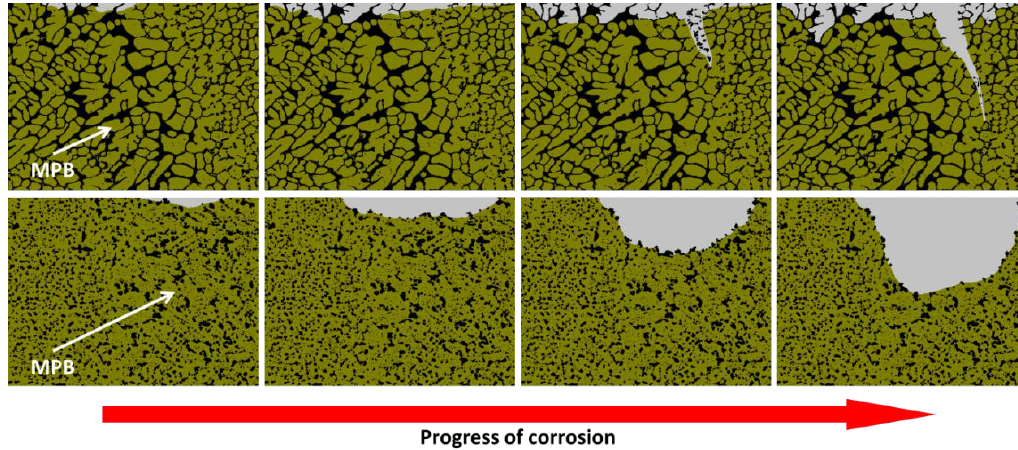
Figure 10. Schematic diagram representing the evolution of the corrosion attack for two separate cases: ( top ) When a connected Si network is present, as is the case for as-built AM Al-Si specimens, and ( bottom ) when the Si is broken up in separate precipitates, as is the case for heat-treated AM Al-Si parts at relatively high temperatures (~300 ◦ C or higher). The illustrations portray the corrosion process seen from a cross-sectional perspective, with the top side of the images representing the surface exposed to the corrosive medium. The Al phase is represented with green, while black portrays the Si phase. For as-built as well as heat-treated specimens, the corrosion initiates at the melt pool borders (MPB), due to the higher driving force for galvanic corrosion in these regions. For as-built specimens corrosion spreads superficially, accompanied by the formation of micro-cracks along the heat-a ff ected zones. On the other hand, a dip and relatively wide penetration of the corrosion attack characterizes heat-treated specimens due to the presence of separate Si precipitates. (Adapted from reference [54]). After stress release at 400 or 500 C for 2 h, no more selective attacks at MPBs were detected after intergranular corrosion tests [52]. Instead, more general corrosion morphologies were noticed. This was linked to a significant modification of the microstructure, showing an α -Al matrix and